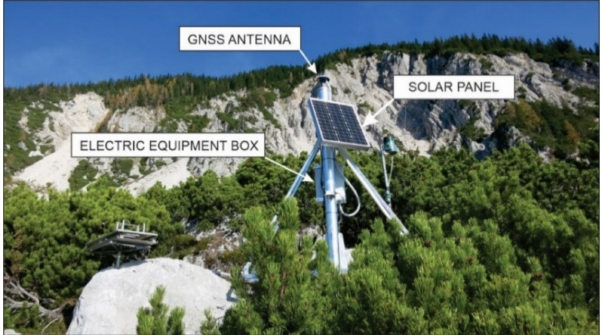
Figure 4. Prototype of a low-cost GNSS unit in the field.